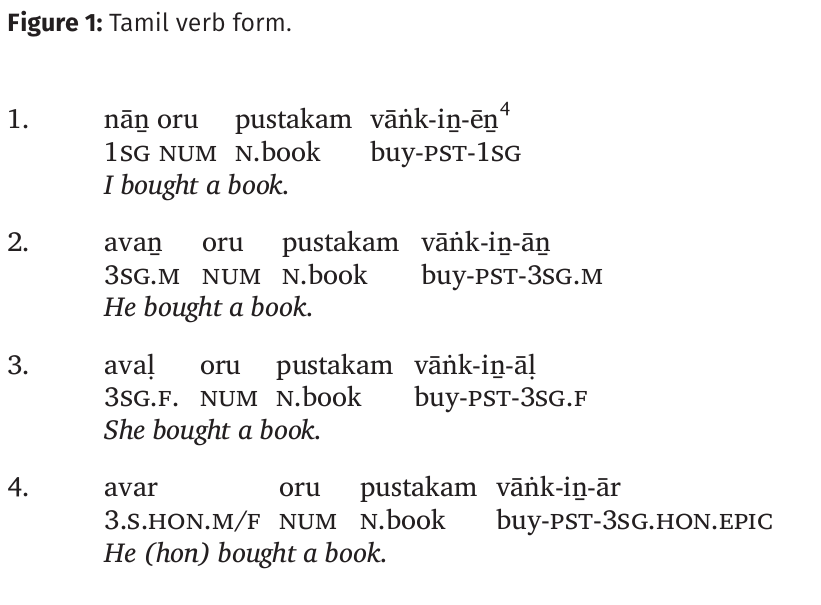
verb form verb stem grammatical